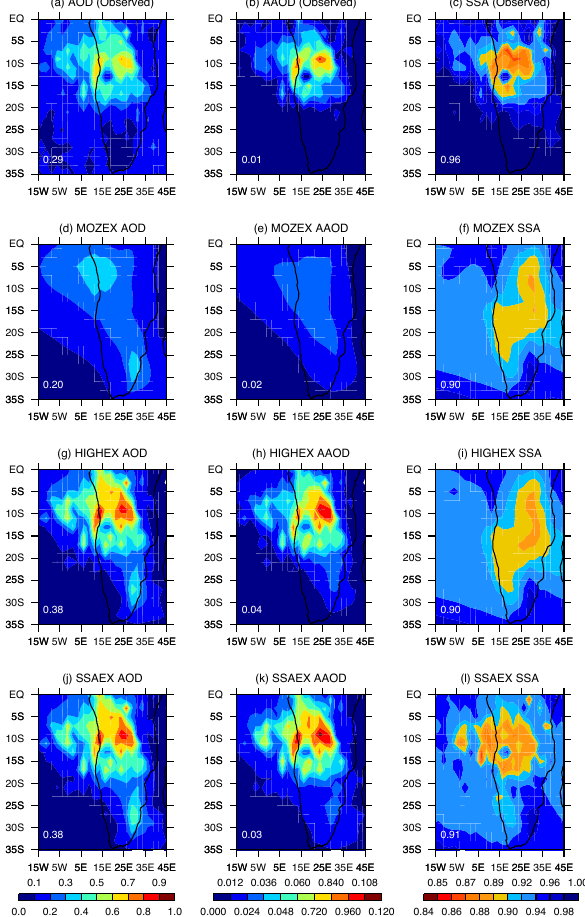
Fig. 1. ASO aerosol optical depth (AOD; left column), aerosol absorption optical depth (AAOD; center column), and single scat- tering albedo (SSA; right column) based on observations from AERONET and EP -TOMS (a–c) , and for MOZEX (d–f) , HIGHEX (g–i) , and SSAEX (j–l) . Recall that HIGHEX, SSAEX, and WHITE (not shown) have similar aerosol mass distributions, so (g) and (j) are nearly the same. MOZEX and HIGHEX have the same OC/BC mass ratio, so the single scattering albedos in (f) and (i) are also similar. Differences arise due to changes in relative humid- ity in each experiment, as described in the text. Land area-averaged (3 ◦ N–37 ◦ S, 19 ◦ W–50 ◦ E) optical properties are given in the lower left of each panel. Note that the optical properties here are for the total aerosol, which includes not only bb aerosols (OC plus BC), but also sulfate (SO 4 ), sea salt, and